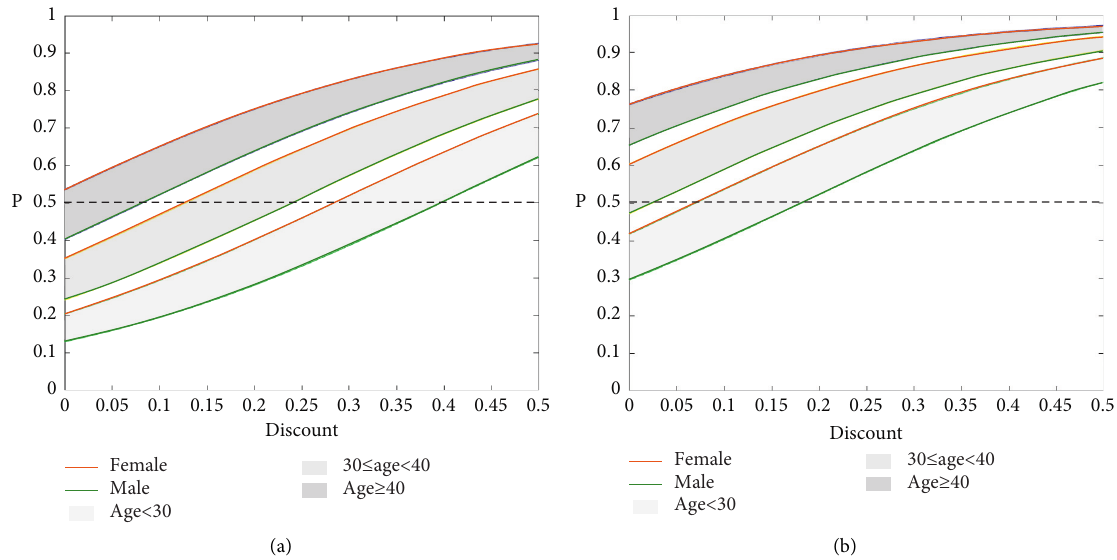
Figure 4: Model prediction of passengers’ willingness to move under different discount. (a) Weekday. (b)